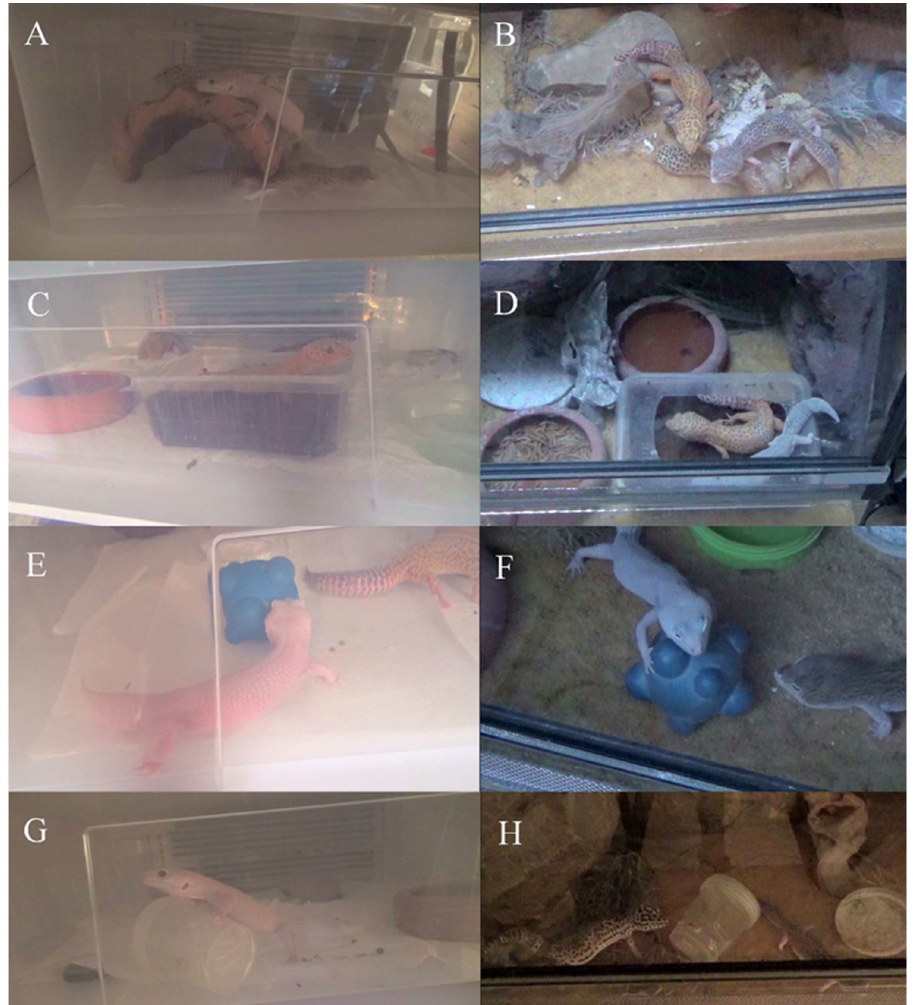
Figure 2. Environmental enrichment items used in the study: ( A , B ) dry hide; ( C , D ) wet hide; ( E , F ) new object; ( G , H ) feeding. ( A , C , E , F ) Rack system; ( B , D , F , H ) biotope terrarium.